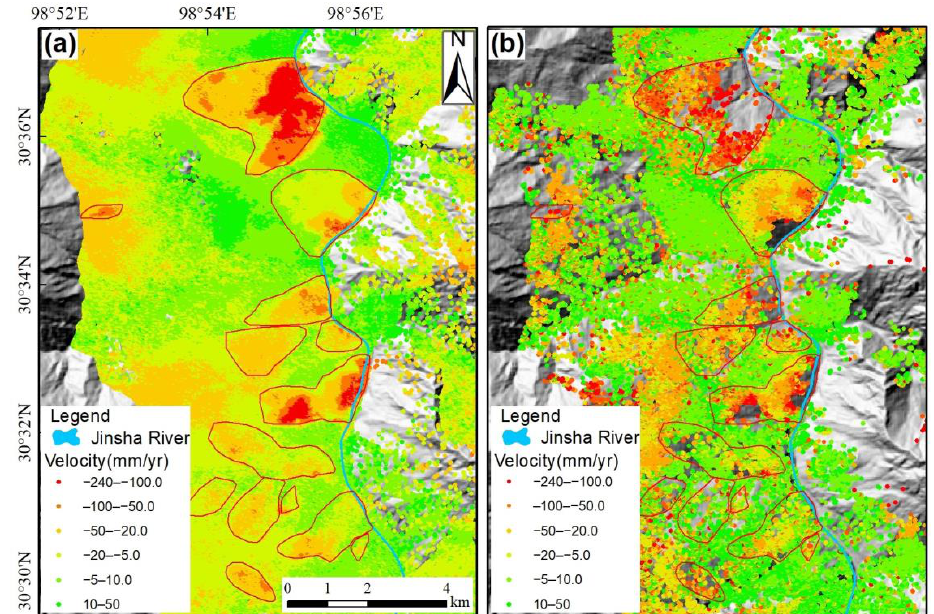
Figure 6. The deformation velocity of the study area was obtained by SBAS ( a ) and PS-InSAR ( b ) methods. Landslide areas are marked with red polygons. (A negative value implies moving away from the satellite; a positive value indicates moving toward the satellite along with the LOS direction).